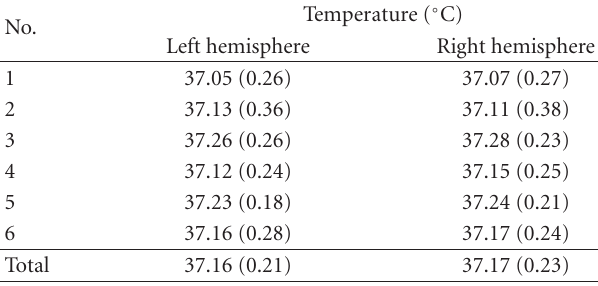
Table 1: Normal brain temperature of